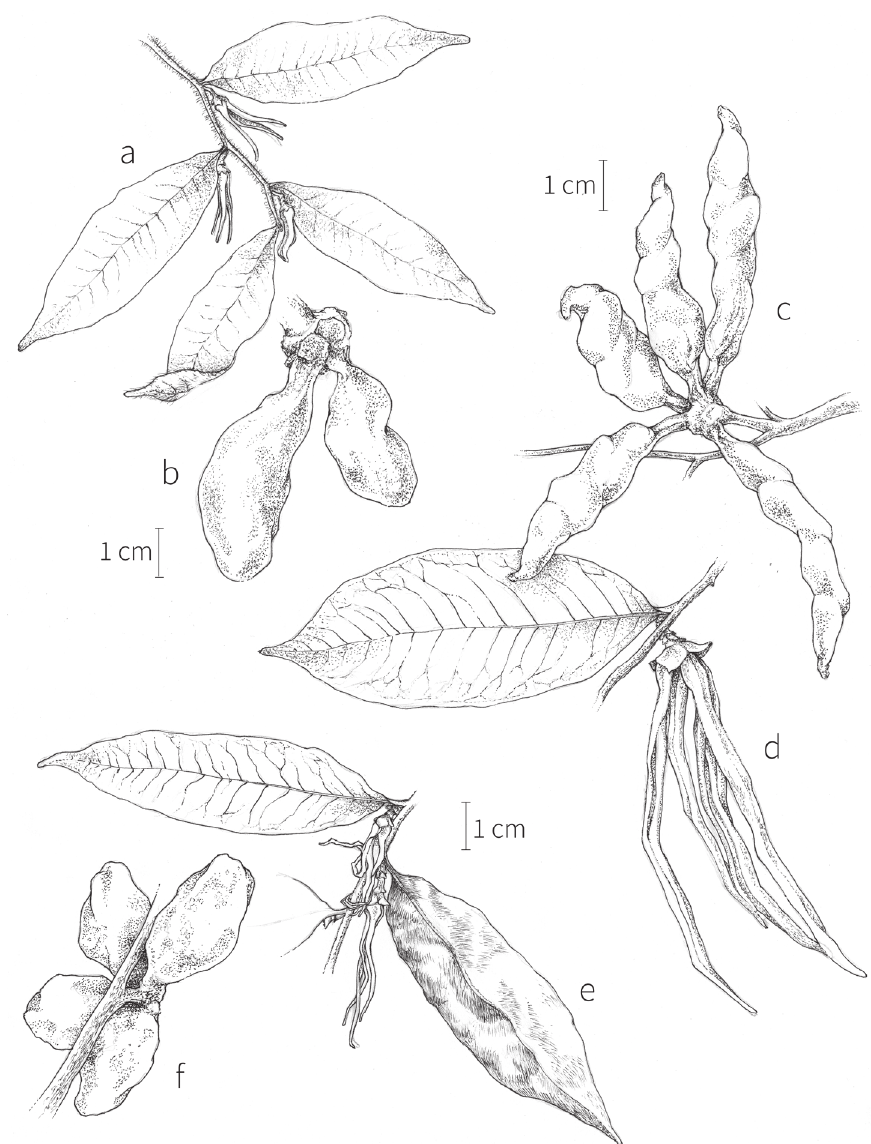
Figure 42. Xylopia pynaertii , X. mildbraedii , and X. hypolampra . A, B X. pynaertii A Habit B Fruit C, D X. mildbraedii C Fruit D Habit E, F X. hypolampra E Habit F Fruit. A from McPherson 13825 (MO) B from Letouzey 12317 (P) C from Breteler et al. 12632 (WAG) D from Reitsma & Reitsma 2816 (NY) E from Le Testu 2023 (F) F from Le Testu 8094 (BM). retuse or obtuse, base obliquely cuneate, rarely rounded or somewhat angular, glabrous except for the pubescent midrib adaxially, densely golden- or silvery-sericeous abaxi- ally; midrib plane adaxially, raised abaxially, secondary veins indistinctly